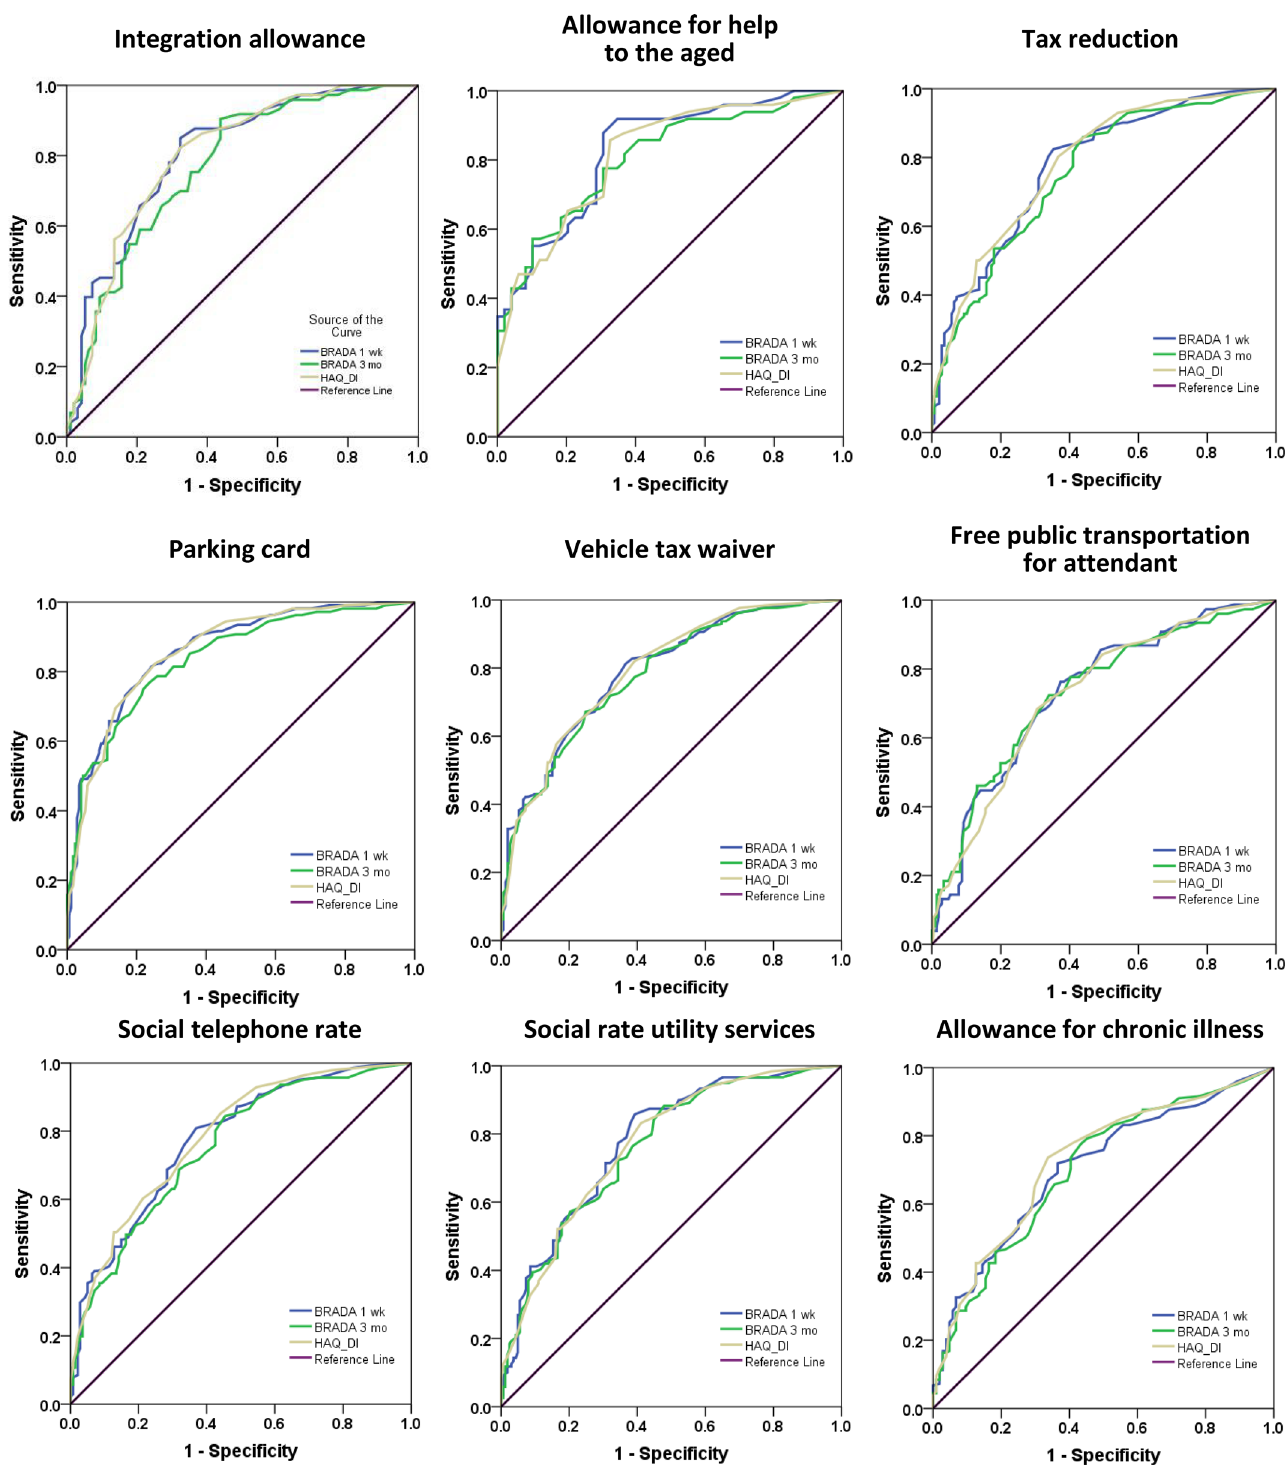
Fig 1. ROC curves comparing BRADA and HAQ as predictors for the need of support measures in patients with RA. Rheumatologists evaluated their patients ’ need for each of the nine support measures currently available in Belgium. Receiver Operator Characteristics Curves (ROC) comparing the performance of the BRADA questionnaire scores with the HAQ in predicting the need for support measures, taking the positive recommendation of the rheumatologist as a reference. These ROCs show that BRADA and HAQ perform comparably well for all support measures evaluated.